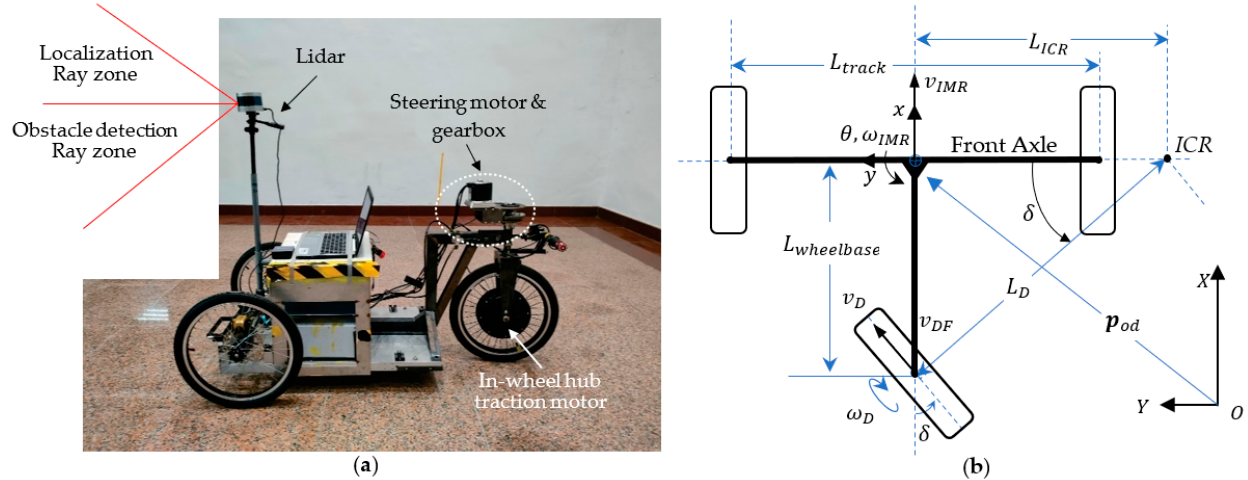
Figure 7. ( a ) The IMR configuration and ( b ) the body (or bogie) schematics of